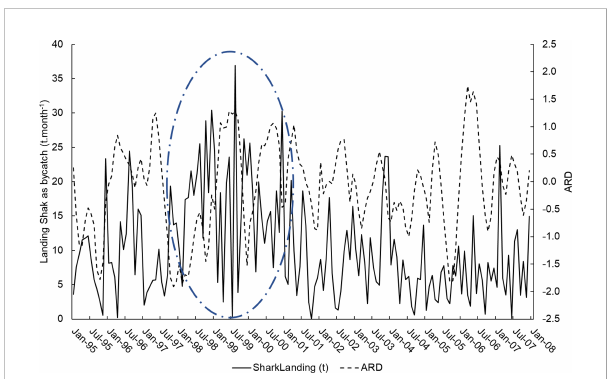
FIGURE 4 Monthly shark bycatch landed by the acoupa weak fi sh ( Cynoscion acoupa ) gillnet fi sheries between January 1995 and December 2007 (solid line) and the Amazon River Discharge (ARD) for the same period (dashed line). The dot-dash line represents the persistent, strong La Niña recorded between 1998 and